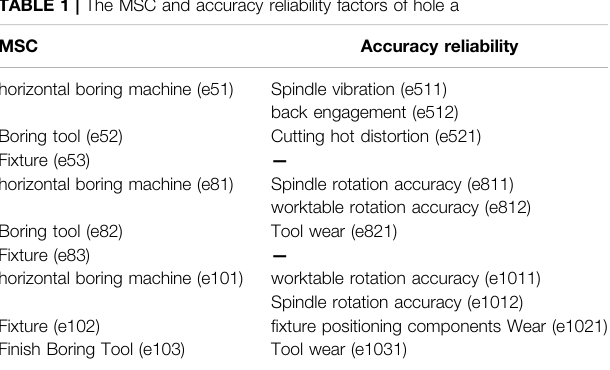
TABLE 1 | The MSC and accuracy reliability factors of hole a TABLE 2 | Algorithm result of nodes control